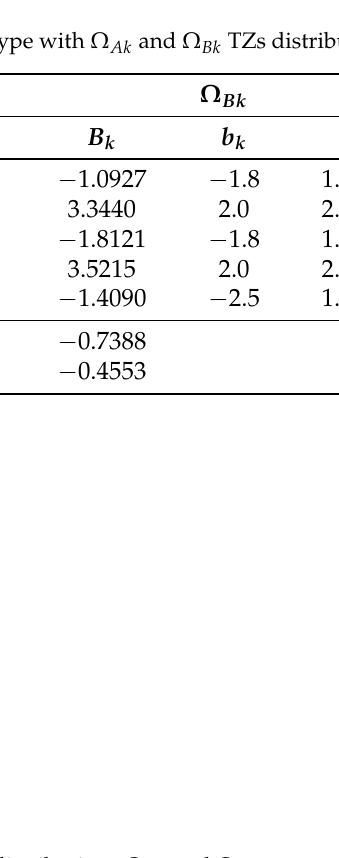
Figure 2. S-parameters of the extracted filter using TZs distributions Ω Ak and Ω Bk